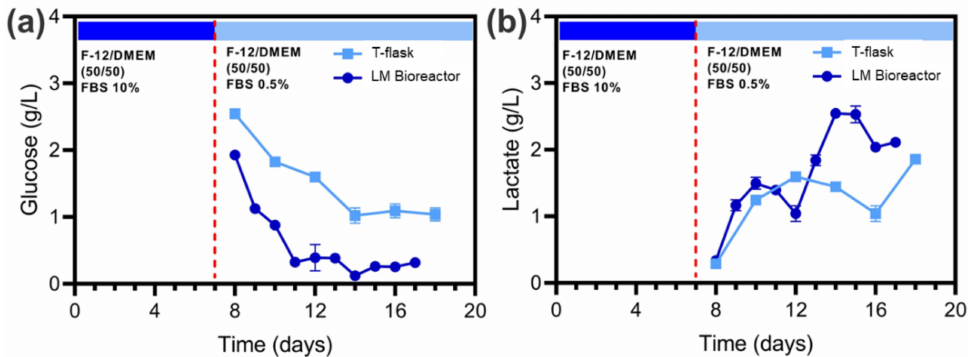
Figure 5. The concentration of ( a ) glucose and ( b ) lactate in T-flasks and large-area microfluidic bioreactor during the production phase from day 8 to 17. Error bars indicate standard error of the mean